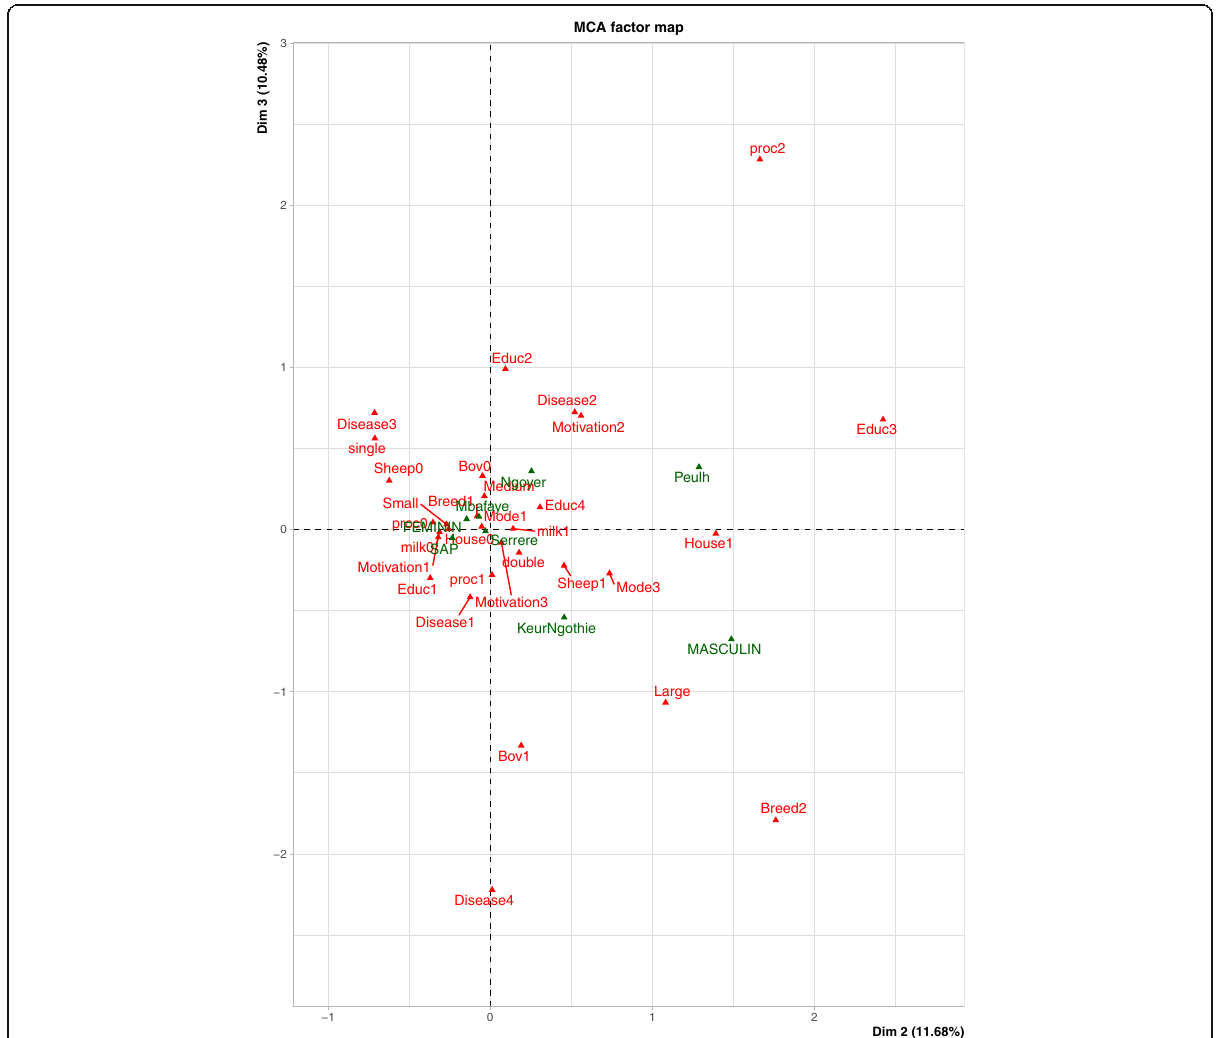
Fig. 3 Modalities associated to axes 2 and 3 of MCA applied to the typology of goat production systems in the Fatick region, Senegal (see Table 1 for the signification of